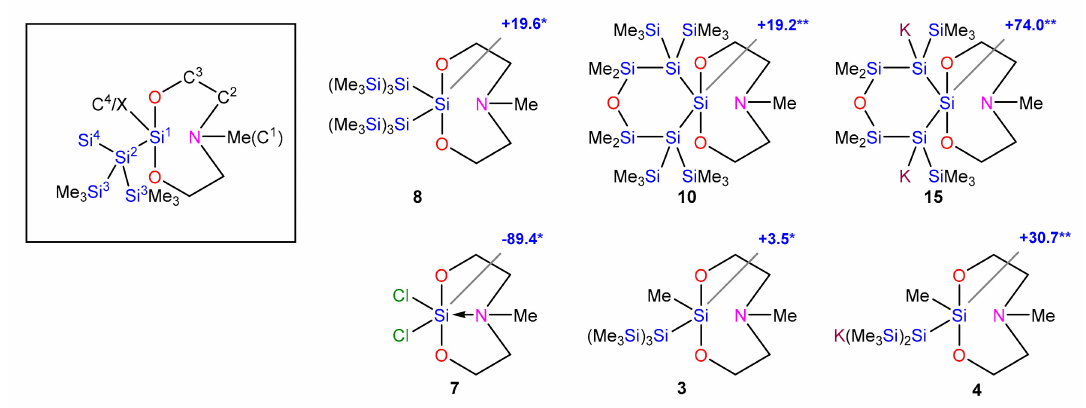
Table 1 is given in the boxed structure. The 29 Si-NMR chemical shift of the quaternary SiO 2 fragment is most strongly influ- enced by its chemical environment exhibiting values ranging from δ Si = − 91.7 ppm for the dimethoxy compound 6 to δ Si = +91.5 ppm for 14 (Table 1, Scheme 1). The situation is somewhat alike to that of the analogous silatranes. The chemical shift of chlorosi- latrane ( − 85.9 ppm) is similar to that of 6 and 7 . The signals of 3 (+3.5 ppm) and 8 (+19.5 ppm) reflect the downfield shift associated with the change of an alkoxy substituent for either a methyl or oligosilanyl group. One unusual feature of the silatranyloligosi- lanide NMR spectroscopy was the unusually strong downfield shift of the silatranyl Si signal upon silanide formation [3,5]. Starting from a resonance for the silatranyl silicon atom of tris(trimethylsilyl)silylsilatrane of δ Si = − 52.8 ppm, the respective silanides ob- tained by abstraction of a trimethylsilyl group resonated at − 11.8 ppm, yielding a ∆ δ Si of +40.8 ppm. Comparison with the conversion of (MeO) 3 Si Si(SiMe 3 ) 3 ( δ Si = − 32.2